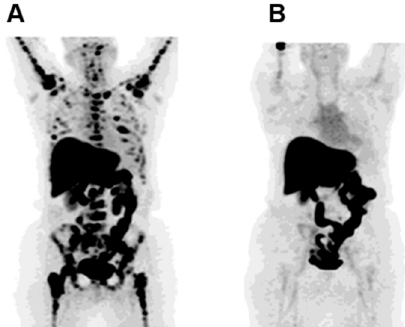
Figure 1. Complete suppression of 16a-18F-fluoro-17b-estradiol (FES)-avid lesions during GDC-0810 treatment. ( A ) Maximum intensity projection (MIP) FES- Positron Emission Tomography (PET) image physiologic. ( B ) MIP FES-PET image, after 2 cycles of GDC-0810 therapy, highlighted the drastic